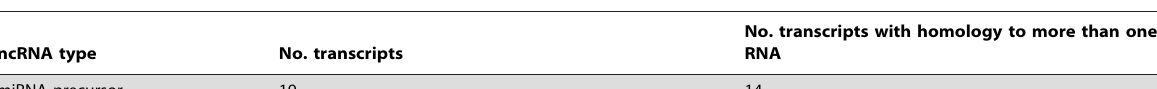
Full-length cDNA ID Sequence with highest scoring alignment